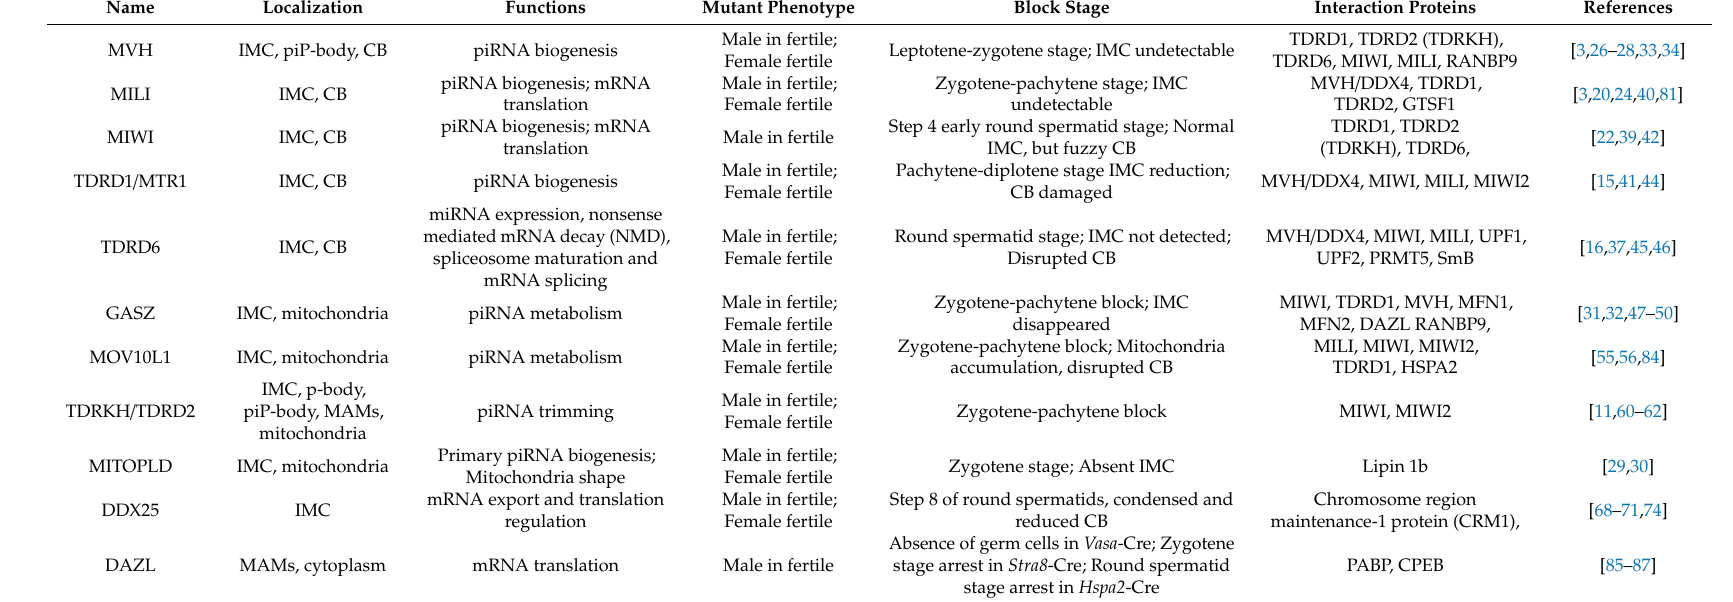
Table 1. The components of mitochondria-associated germinal structures in murine testes are